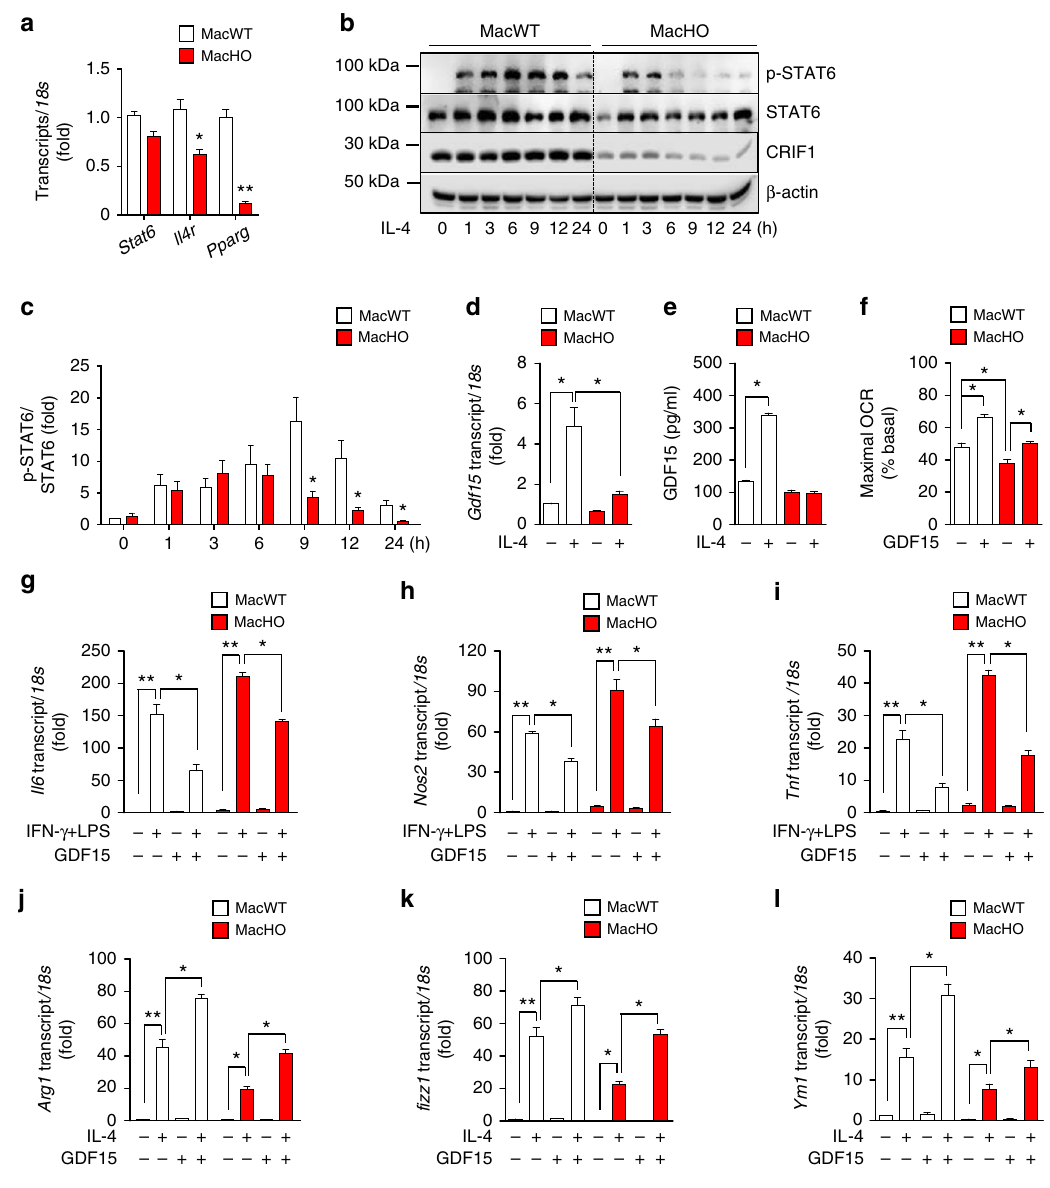
Fig. 7 Macrophages from MacHO mice secrete less GDF15 upon stimulation with rIL-4. a Real-time PCR analysis of Stat6 , Il4r , and Pparg gene expression in BMDMs from 8-week-old MacWT and MacHO mice. b , c Immunoblot analysis of STAT6 phosphorylation in BMDMs from 8-week-old MacWT and MacHO mice after treatment with rIL-4 (100 ng/ml). d Real-time PCR analysis of Gdf15 mRNA expression in BMDMs from 8-week-old MacWT and MacHO mice in the presence/absence of rIL-4 (100 ng/ml). e GDF15 levels in culture supernatants of MacWT and MacHO BMDMs from 8-week-old mice after treatment with rIL-4 (100 ng/ml) for 48 h. f OCR in BMDMs from 8-week-old MacWT ( n = 5) and MacHO mice ( n = 5) treated with rGDF15 (300 ng/ml) for 24 h. g – i Real-time PCR analysis of Il6 , Nos2 , and Tnf mRNA after treatment with rGDF15 (300 ng/ml) in the presence or absence of IFN- γ (10 ng/ml) and LPS (100 ng/ml). j – l Real-time PCR analysis of Arg1 , Fizz1 , and Ym1 mRNA expression after treatment with rGDF15 (300 ng/ml) in the presence/absence of rIL-4 (20 ng/ml). Data are expressed as means ± SEM and are representative of three independent experiments. * p < 0.05 or ** p < 0.01 (two-tailed Student ’ s t